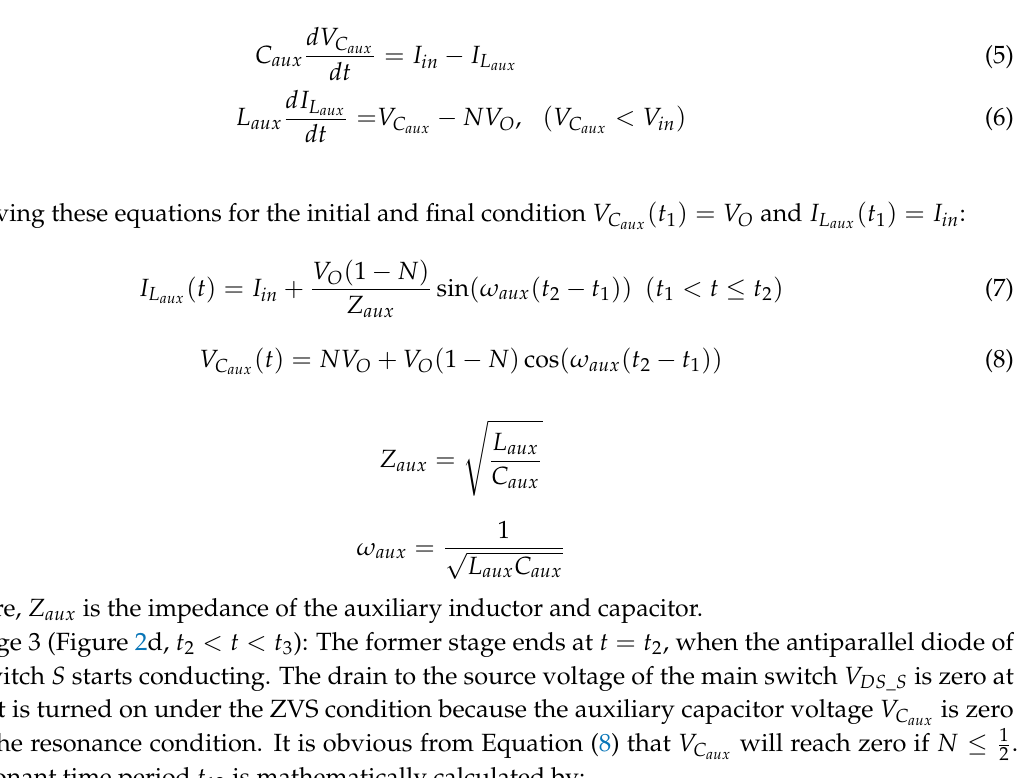
(Figure 2d, t 2 (cid:48) < t < t 2 ): In this stage, the voltage still continues to decrease as I L auxiliary transformer voltage NV O < V O /2, then V C